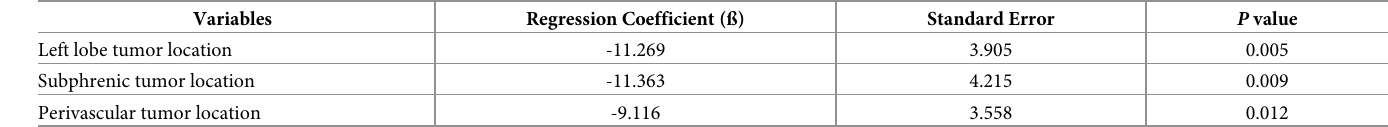
Table 4. Multiple linear regression analysis of hepatocellular carcinoma volume reduction rate after radiofrequency ablation.